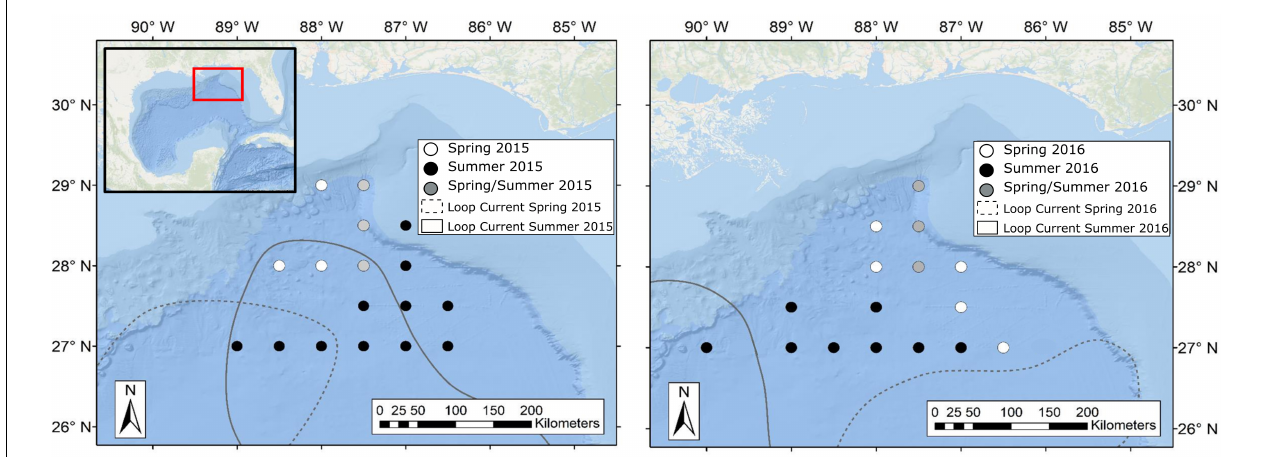
FIGURE 2 | Maps of the northern Gulf of Mexico showing sample collection locations during spring (white circles), summer (black circles), and spring and summer (gray circles) for oceanographic cruises conducted in 2015 (left panel) and 2016 (right panel). Dashed and solid lines represent approximate location of the Loop Current defined by 20-cm sea surface height anomaly (SSHA) during spring and summer sampling periods, respectively. Water surrounding the Loop Current was classified as Gulf Common Water following Johnston et al. (2019). Loop Current positions were created using remotely sensed sea surface height data available through the Copernicus Marine Environmental Monitoring